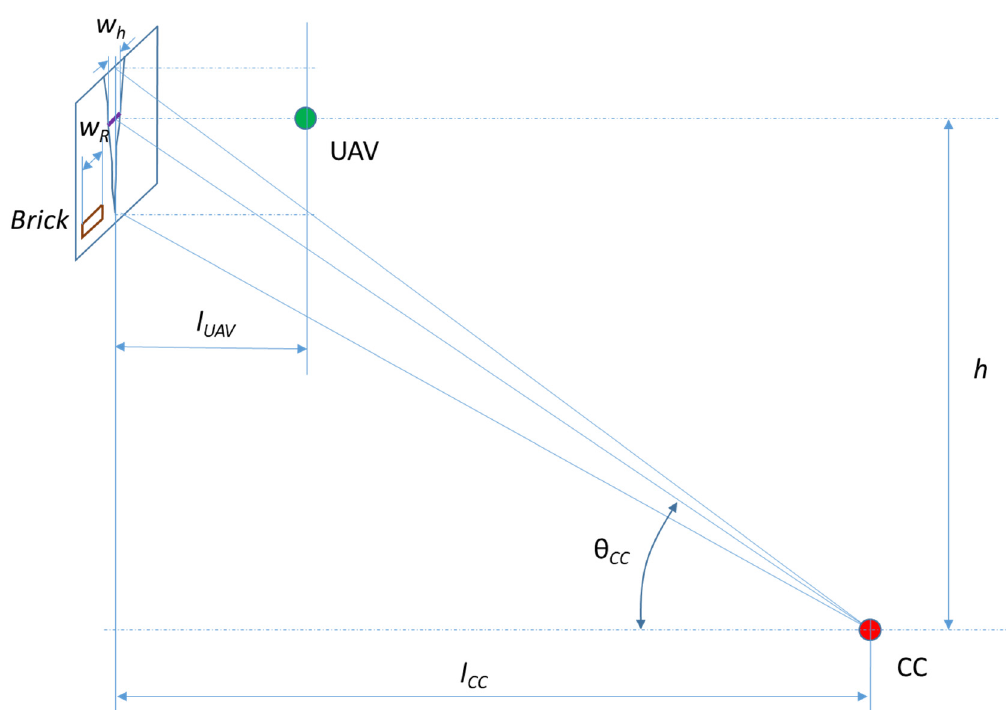
Figure 9. Comparison between conventional and UAV application photograph. The different variables are: CC : Conventional camera position; UAV : UAV position; h : UAV flight height; l UAV : Distance from the UAV to the element to be measured; l cc : Distance from the conventional camera to the element to be measured; θ cc : Conventional camera angle observation with the element to be measured; W R : Reference dimension